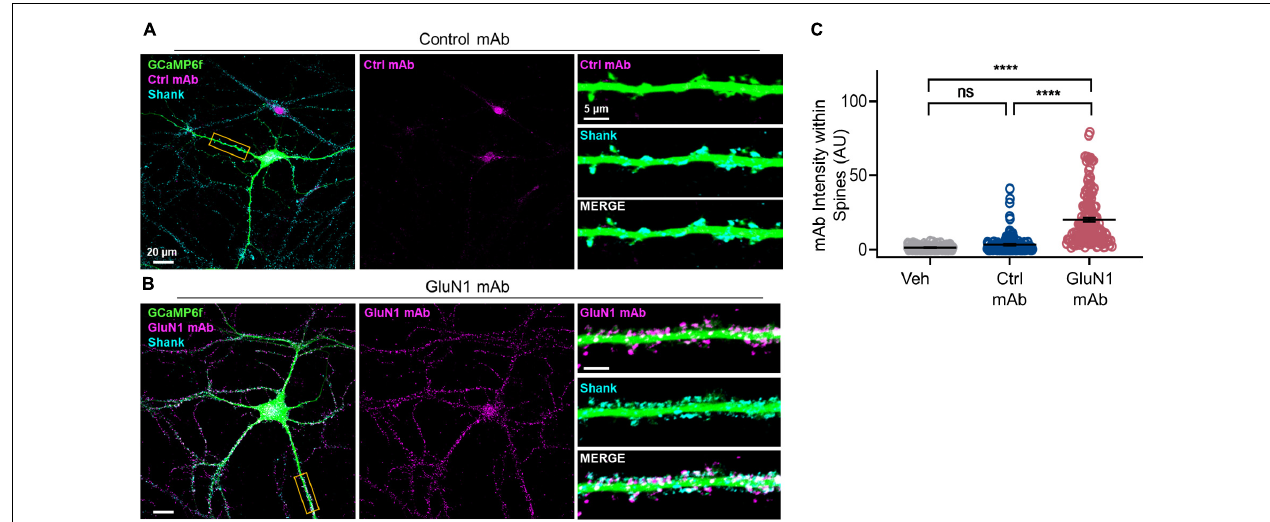
FIGURE 2 | Human GluN1 monoclonal antibodies rapidly localize to spines in live hippocampal primary neuron culture. (A) Representative cultured hippocampal neuron transduced with GCaMP6f (green) and stained for human mAb (magenta) and synaptic marker Shank (cyan) following control mAb exposure. Right top, zoom in of boxed dendrite in left showing GCaMP6f and Ctrl mAb (magenta). Right middle, GCaMP6f and Shank (cyan). Right bottom, zoom in of GCaMP6f, human mAb, and Shank. Note lack of human control mAb labeling. (B) Representative hippocampal neuron, as in panel (A) , exposed to GluN1 mAb. Right bottom, note co-labeling of Shank with human GluN1 mAb (white). (C) Quantification of human mAb staining intensity at spines. A Kruskal-Wallis test with post-hoc Dunn’s revealed a statistically significant difference in mAb labeling between groups [ H (3) = 240, p < 0.0001]. Control mAb labeling at spines was not significantly above background levels of vehicle (ns, p = 0.1) and mAb spine labeling was significantly different between GluN1 mAb and vehicle ( p < 0.0001) and between GluN1 mAb and control mAb ( p < 0.0001). Ctrl, control; mAb, human monoclonal antibody; ns, not significant; Veh, vehicle; **** p < 0.0001; ns, p >